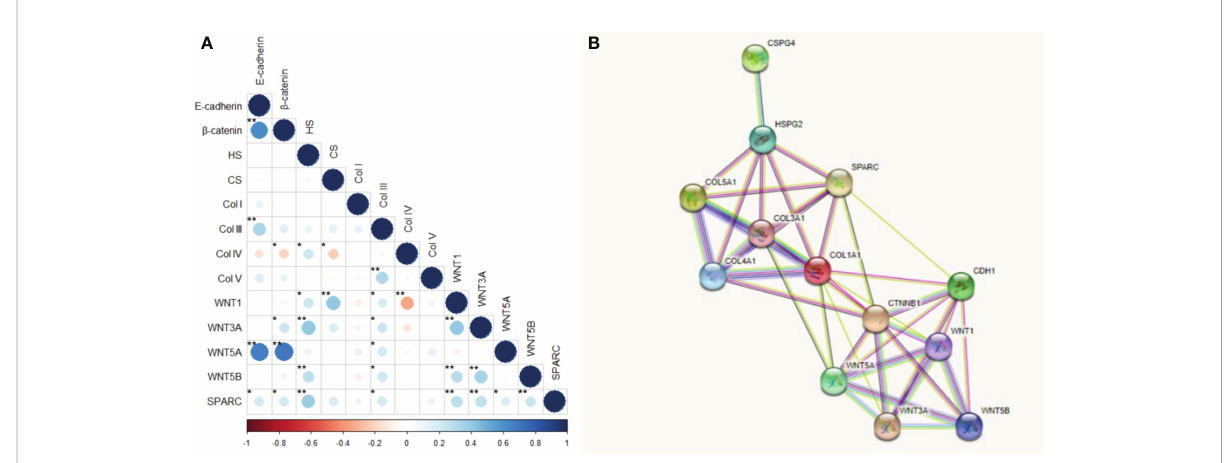
FIGURE 11 Correlation and protein-protein interaction network. (A) Correlation between the interest markers. The graduation of colors represents the positive or negative correlation. The size of the dot represents the Spearman ’ s rho, larger dots have values closer to |1|, therefore, more strong correlation. *P<0.05; **P<0.01. (B) Protein-protein interaction network obtained into the STRING tool for our interest